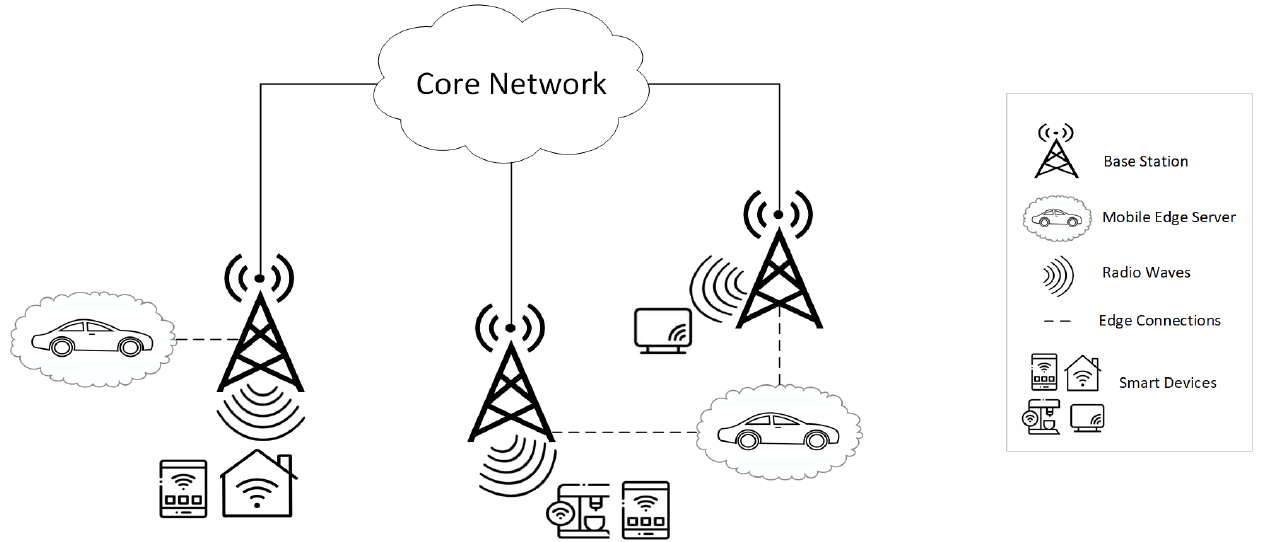
Figure 1. Edge servers placement in mobile edge